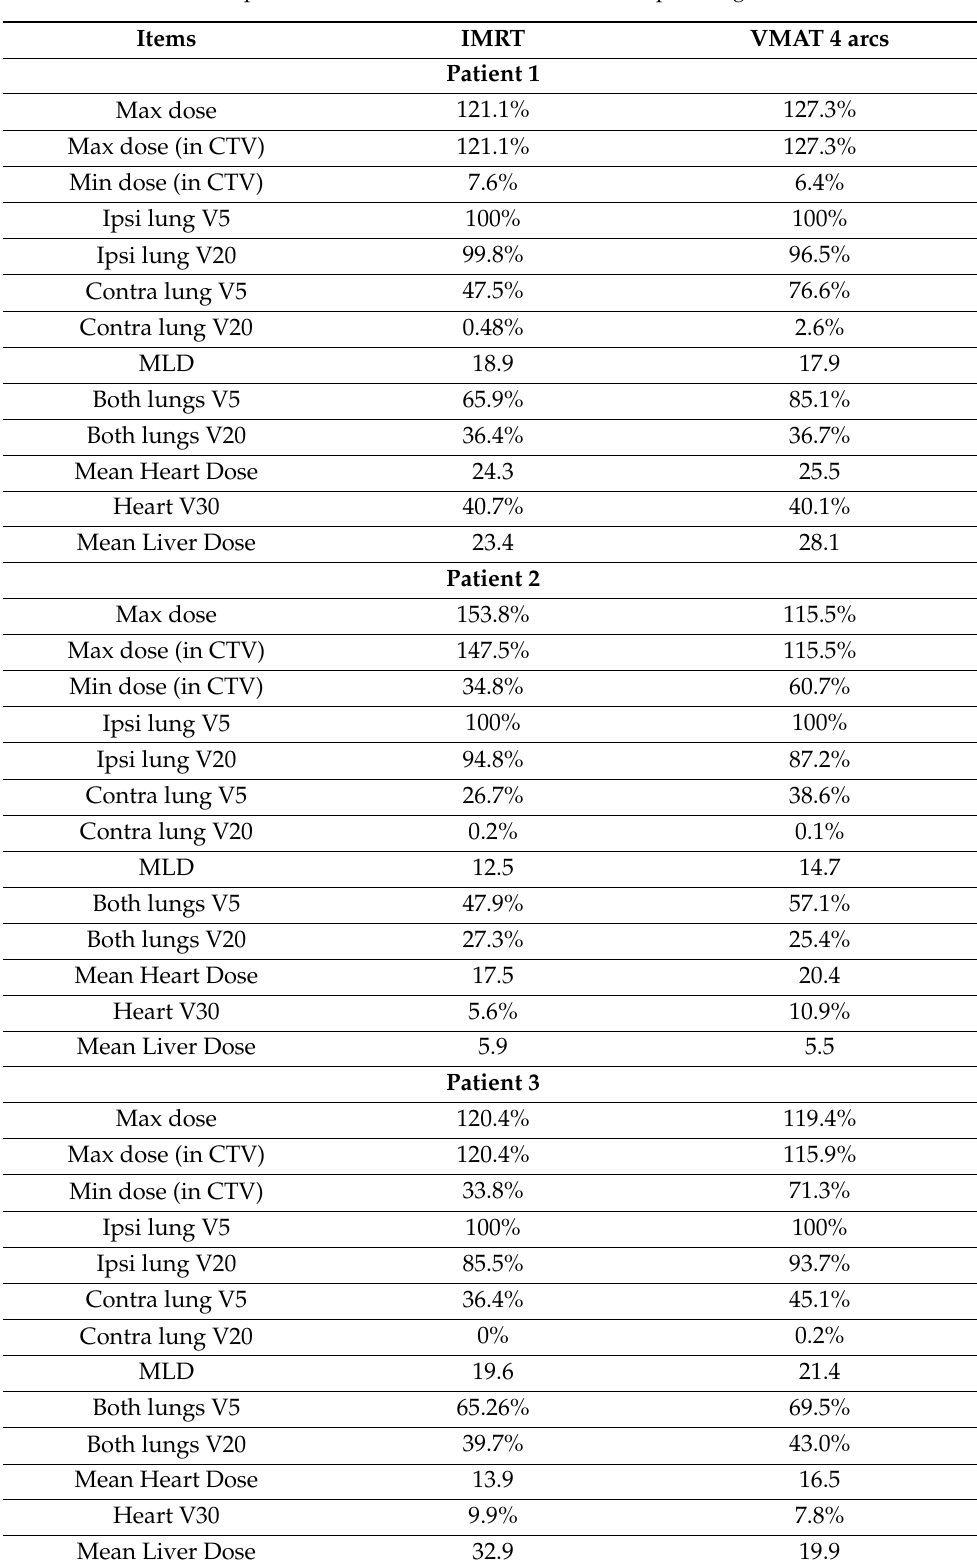
Table 3. Dosimetric comparison between IMRT and VMAT-based